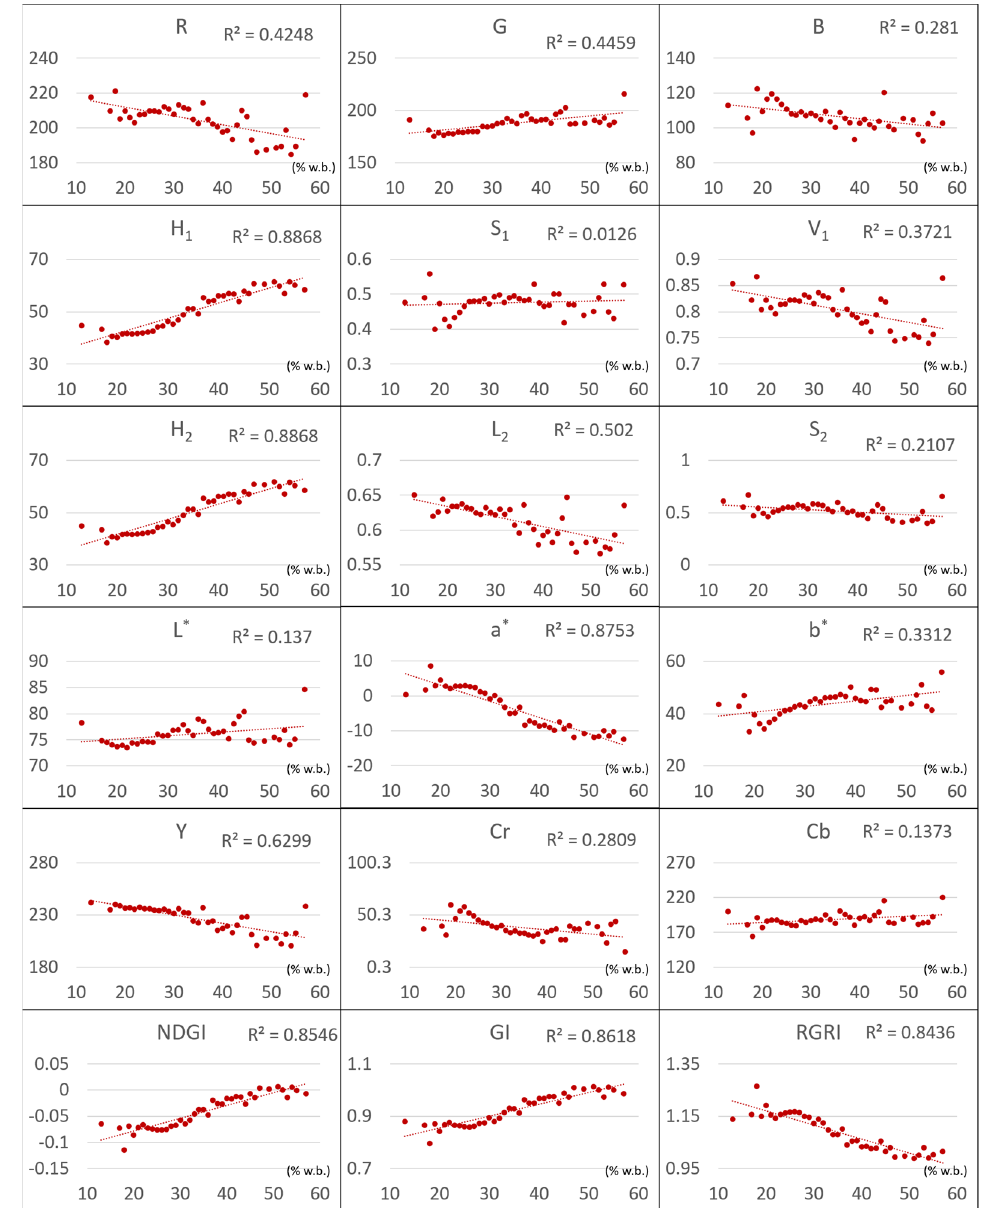
Figure 13. The distribution of color index and different GMC (x-axis: % w.b. and y-axis: value of CIs).